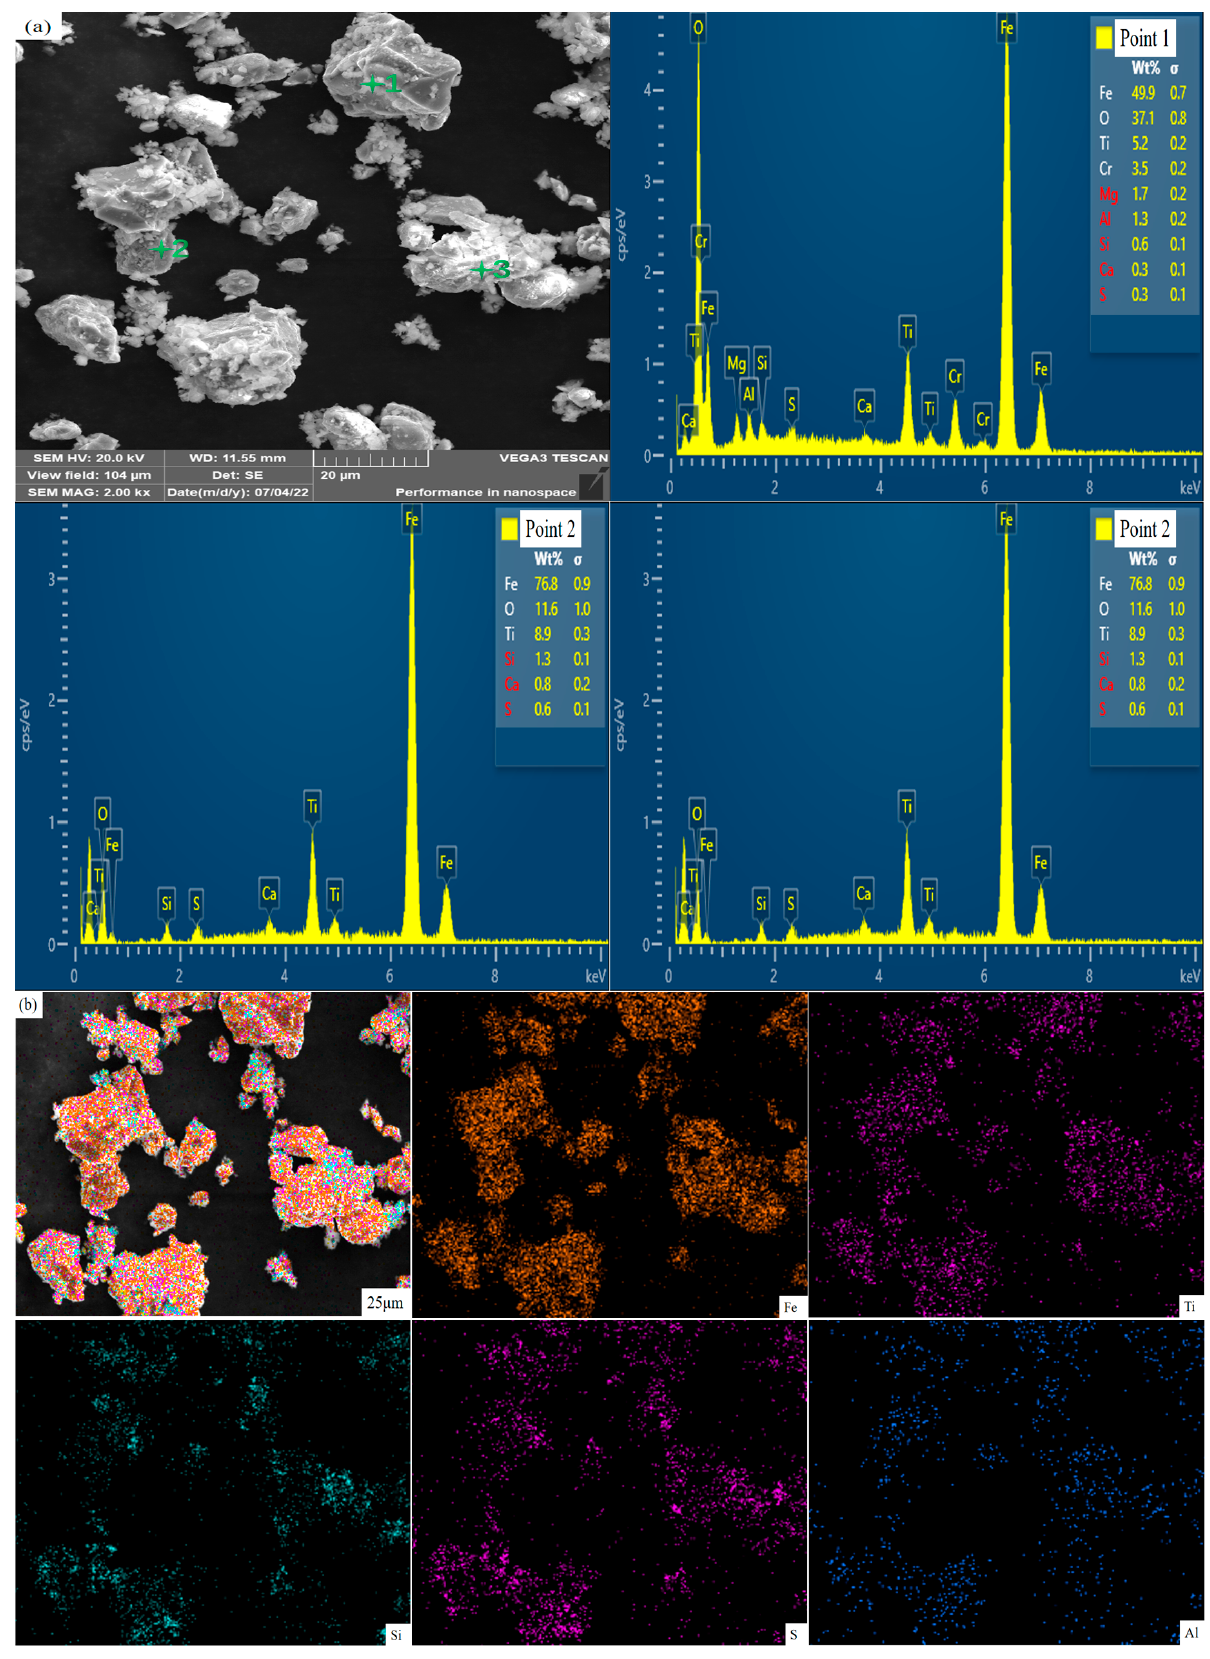
Figure 8. SEM ( a ) Spot scan, ( b ) Face scan images of pellets after leaching.